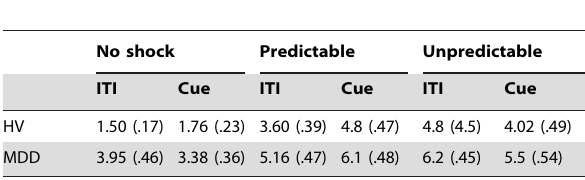
Table 2. Mean (sem) Retrospective subjective ratings of fear and